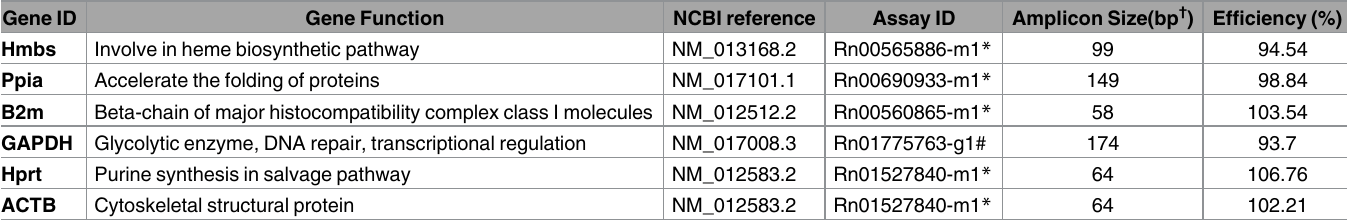
Table 1. Description and efficiency of six referencegenes, used for